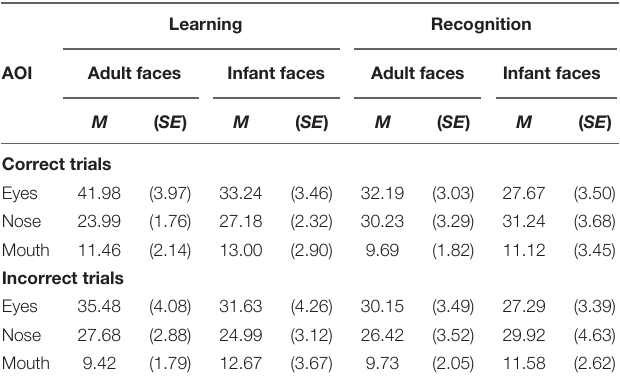
TABLE 4 | The mean and standard error of the percentage of total looking time on each of the three AOI (eyes, nose, mouth) on the adult and infant faces separately for the learning and recognition